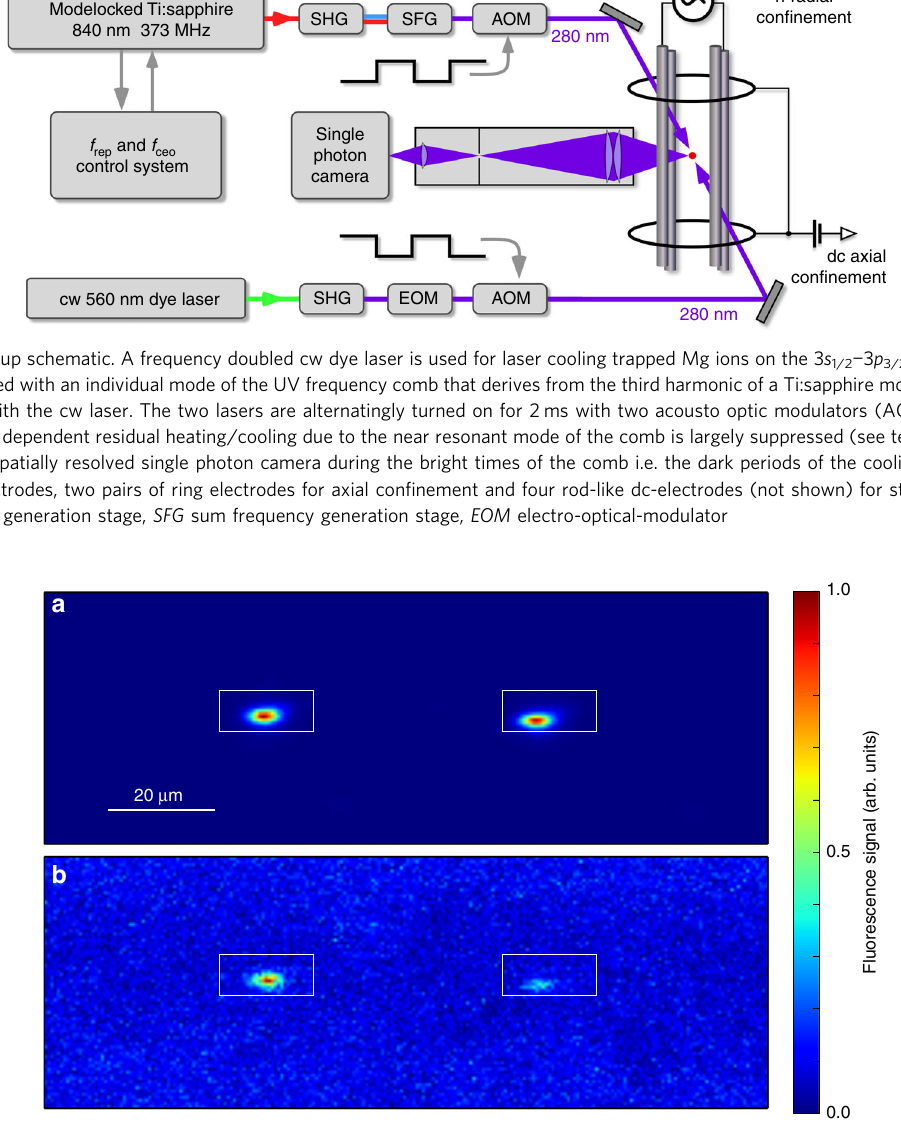
Fig. 2 Ion images. Typical ion images for a cooling and b spectroscopy periods. We use one or two ions for spectroscopy. When two ions are trapped, the illumination across them is not exactly uniform because their extension exceeds the tightly focused laser beams waists of the frequency comb and cooling laser. The fl uorescence signal is recorded within the ROI denoted by the white rectangles. This area is set to accommodate the average ion position, so it does not necessarily center the ions on each run. Note that the images are normalized independently for a and b